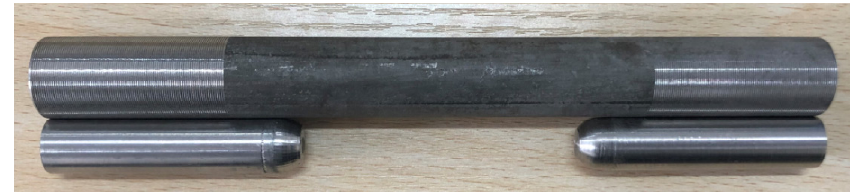
Figure 3. Section sample and stopper.